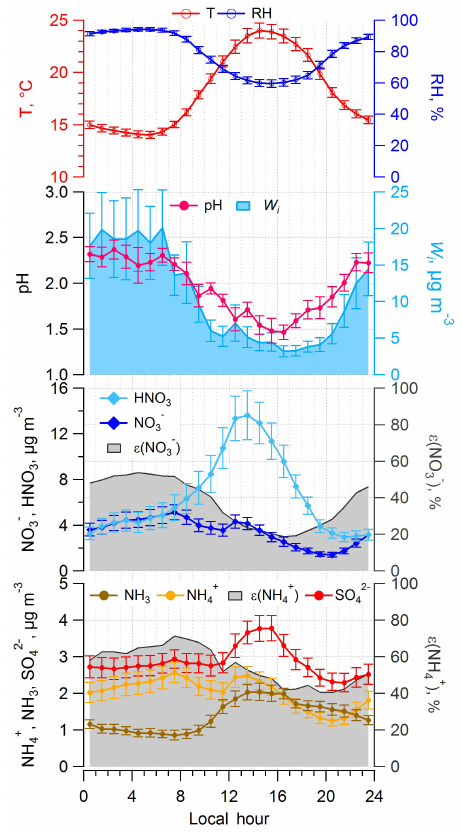
Figure 7. Diurnal profiles for the last week of CalNex of predicted pH and LWC, and measured T , RH, particle- and gas-phase inor- ganic compound mass loadings (SO 2 − NH 3 , HCl), particle-phase fractions ( ε (NO − Particle-phase data are all PILS-IC PM 2 . 5 . Median hourly averages are shown, and standard errors are plotted as error